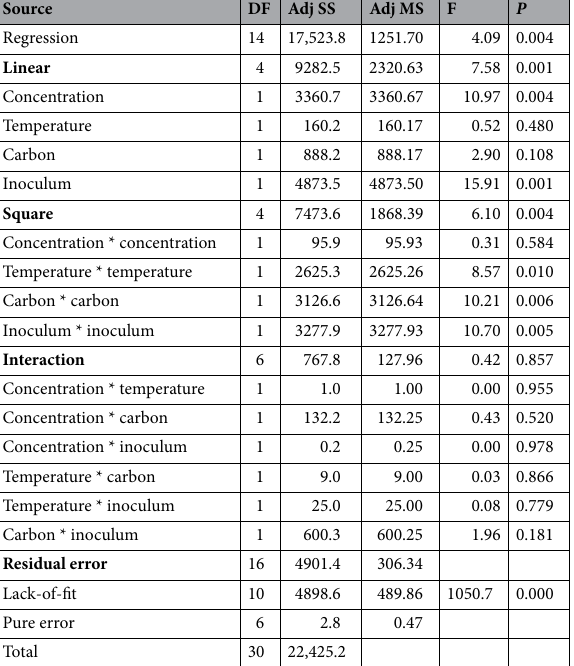
Table 5. ANOVA for central composite design model (CCD).